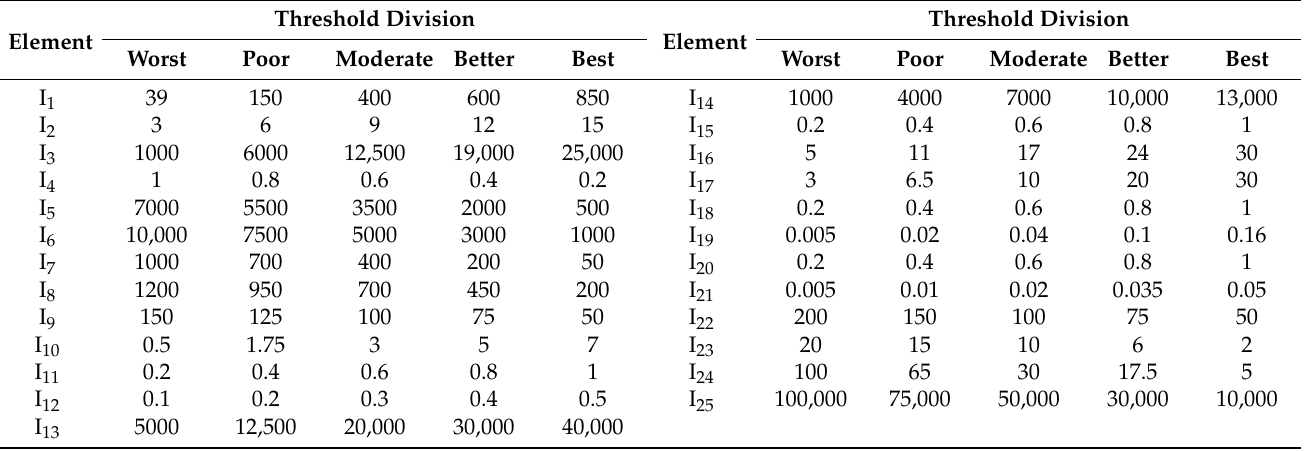
Table 2. Element threshold division table.